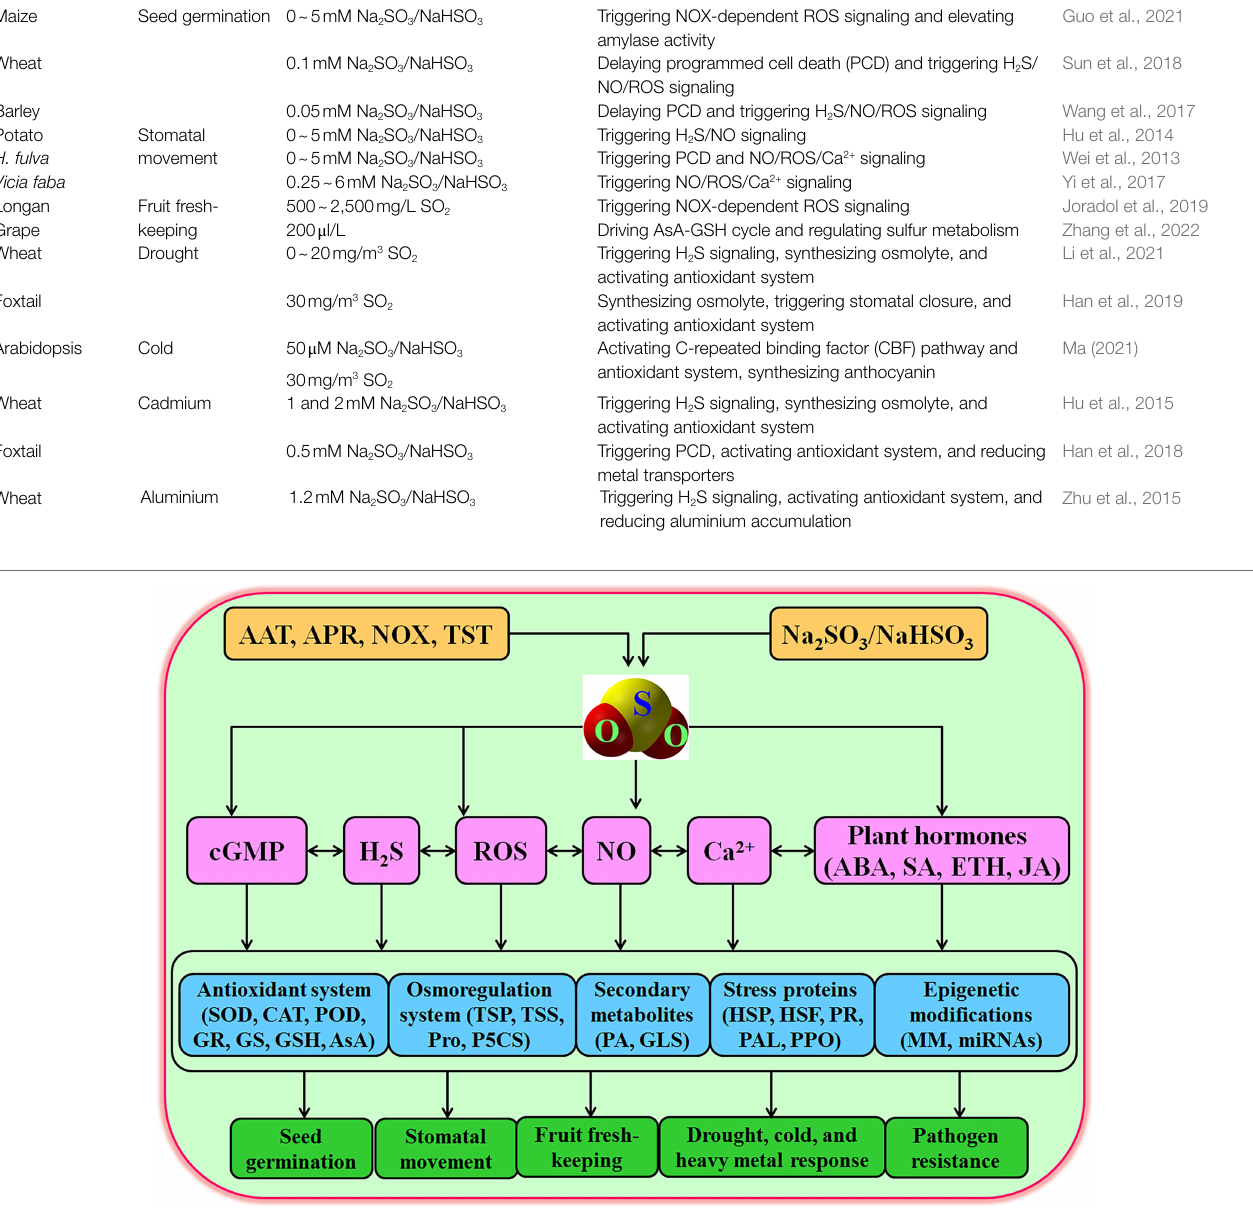
TABLE 1 | Examples of the role of SO 2 signaling in plant growth and response to environmental stress.